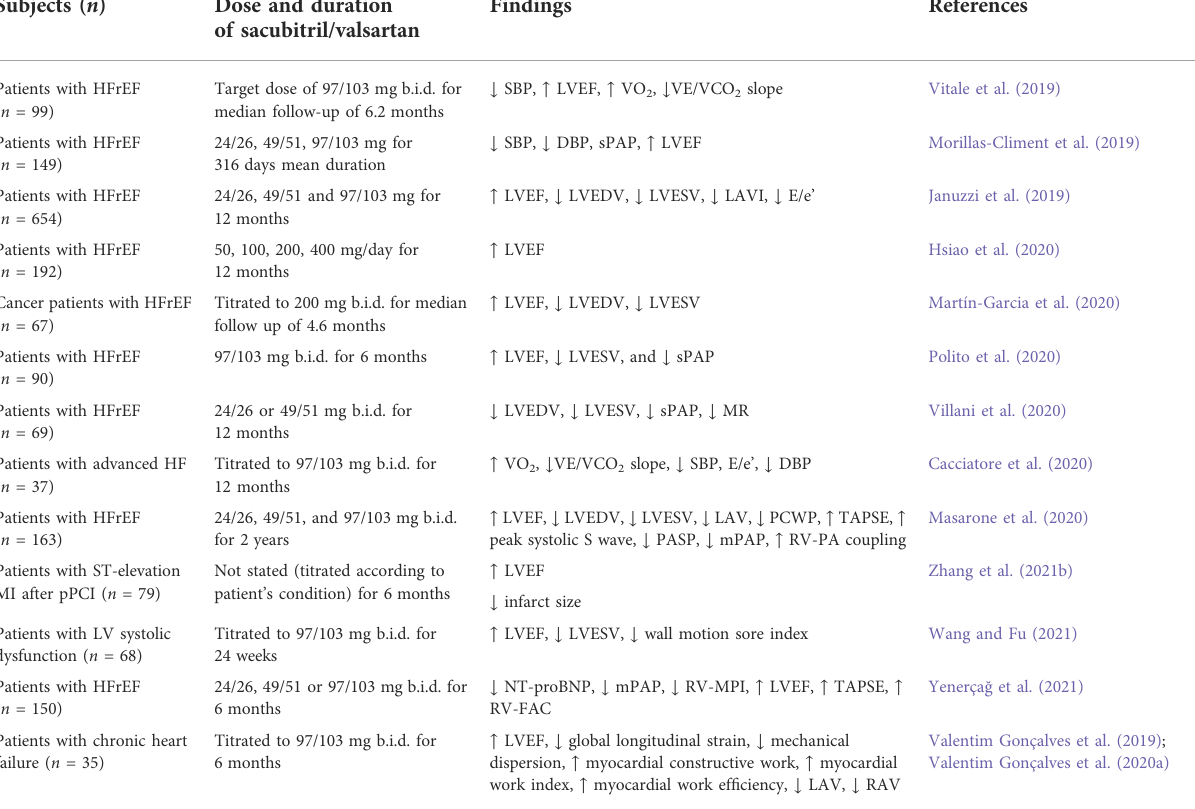
TABLE 1 The effects of sacubitril/valsartan on cardiac function in human studies. Subjects ( n )